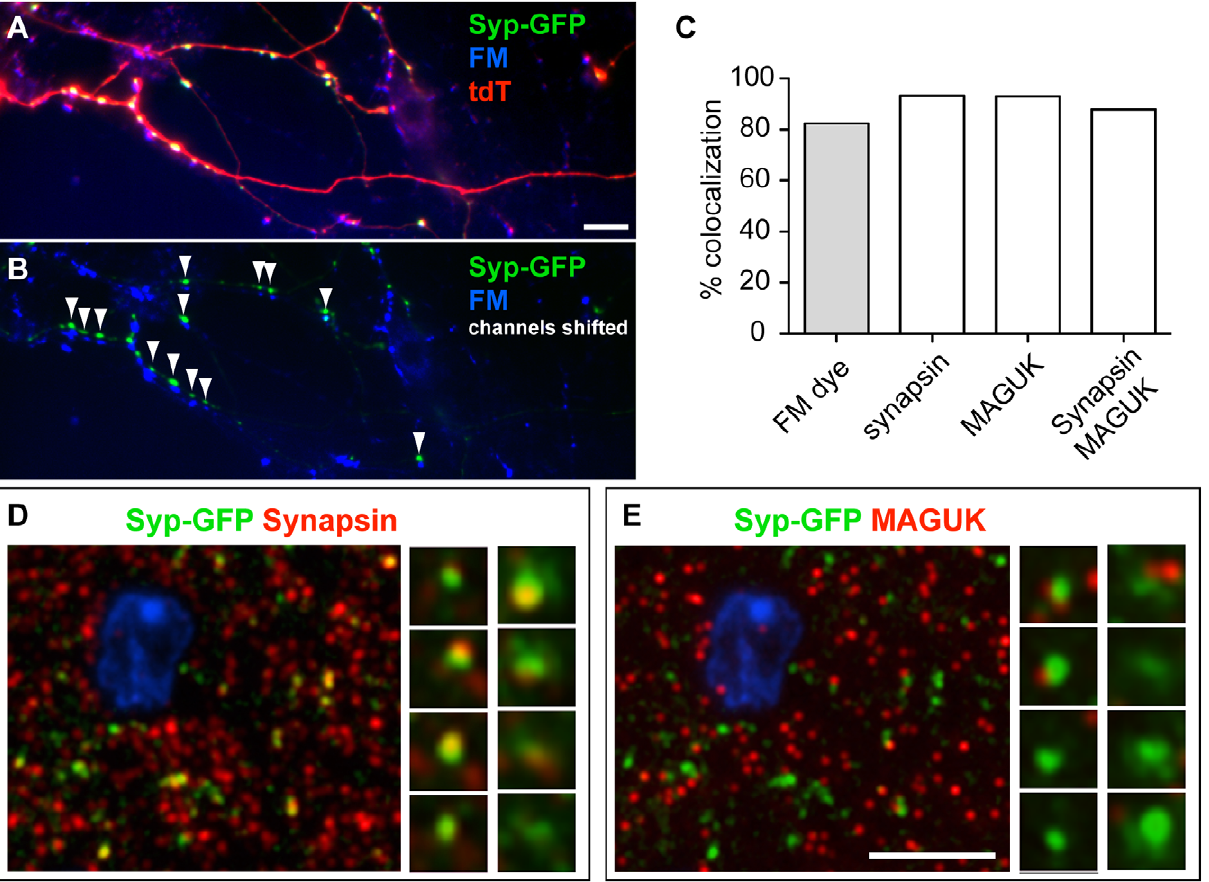
Figure 3. Validation of the synaptic labeling tool. (A) A representative image showing functional presynaptic terminals labeled by FM dye staining (blue) in 14 DIV (days in vitro) dissociated primary hippocampal neurons generated from a P0 triple transgenic mouse pup (ZtTA/wt; TRE-Bi- SG-T/wt; Nestin-Cre/wt). The presynaptic termini, labeled by Syp-GFP (green) and the FM dye (blue) are located on axonal processes (red) and therefore appear white or yellowish. (B) The Syp-GFP and FM-dye channels from panel A have been shifted to show that most Syp-GFP puncta (green, white arrowheads) located along the processes colocalize with FM dye (blue) puncta. Scale bar is 5 m m. (C) Quantification of percentage of Syp-GFP colocalized with FM dye (Grey bar for FM dye experiment in A–B), synapsin and MAGUK (for array tomography experiment in D–E). The total number of counted Syp-GFP puncta is 1176 and 314, for the FM dye experiment and array tomography experiment, respectively. Two animals were used for the FM dye experiment. (D–E) Representative array tomography images from a P35 triple transgenic mouse brain (ZtTA/wt; TRE-Bi-SG-T/wt; b -actin- CreER/wt) with tamoxifen administered at E9.5 showing in vivo presynaptic localization of Syp-GFP puncta. Left panels represent images from a single ultrathin (70 nm) section showing colocalization of Syp-GFP (green) with synapsin (red, C) or MAGUK (red, D). Right panels show two examples